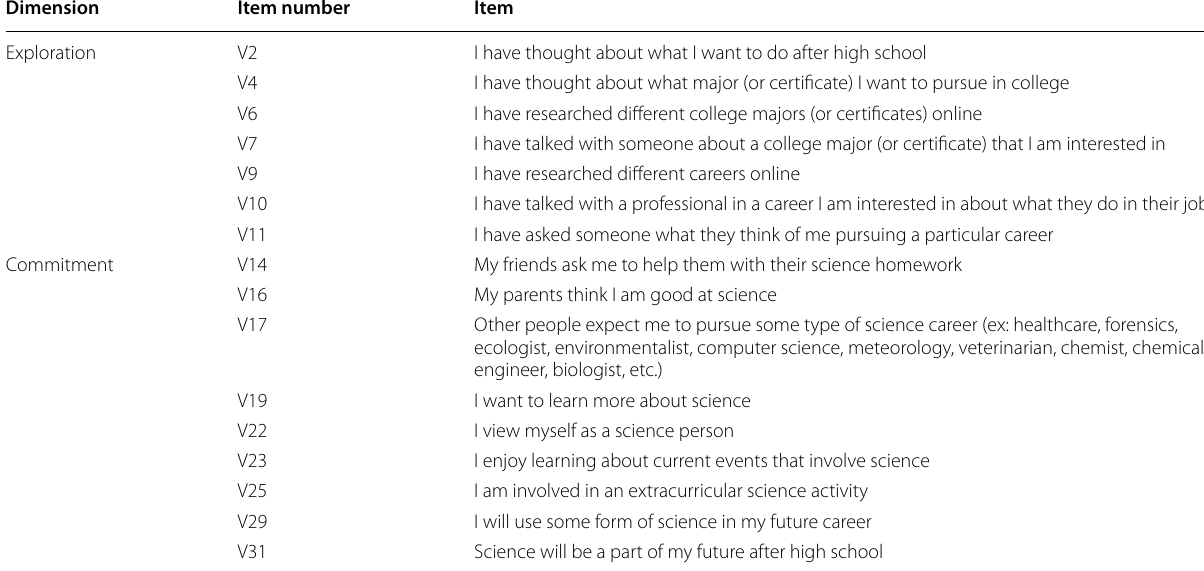
Table 2 SciID Scale 16 items Dimension Item number Item